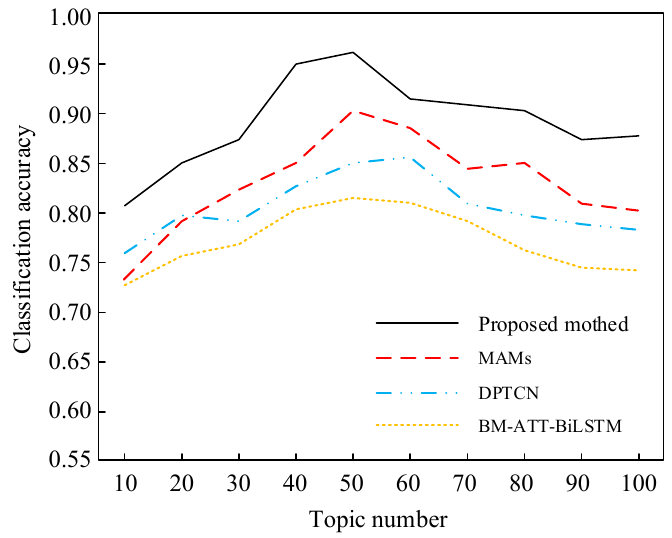
Figure 9. TC accuracy of different methods under SNs dataset.